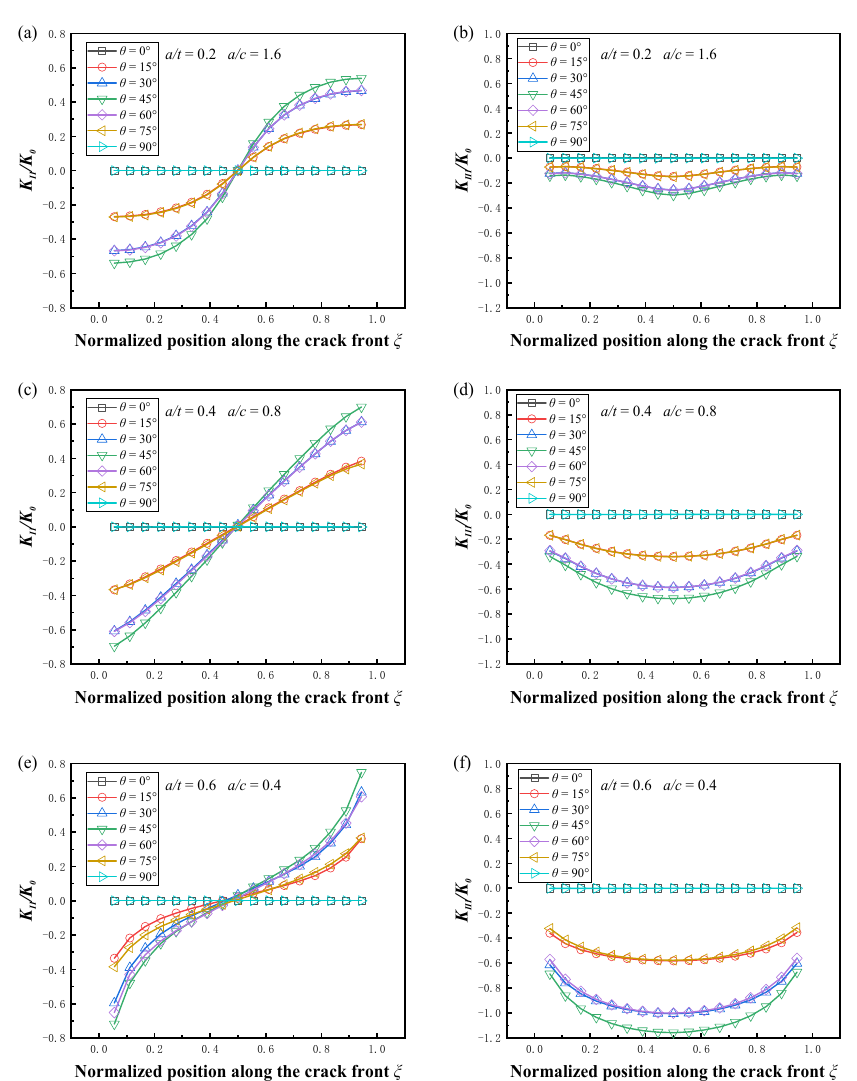
Figure 10. Effect of the inclination angle on the normalized SIFs, µ = 0. ( a ) Normalized K II ( a/t = 0.2, a/c = 1.6); ( b ) normalized K III ( a/t = 0.2, a/c = 1.6); ( c ) normalized K II ( a/t = 0.4, a/c = 0.8); ( d ) normalized K III ( a/t = 0.4, a/c = 0.8); ( e ) normalized K II ( a/t = 0.6, a/c = 0.4); ( f ) normalized K III ( a/t = 0.6, a/c = 0.4).